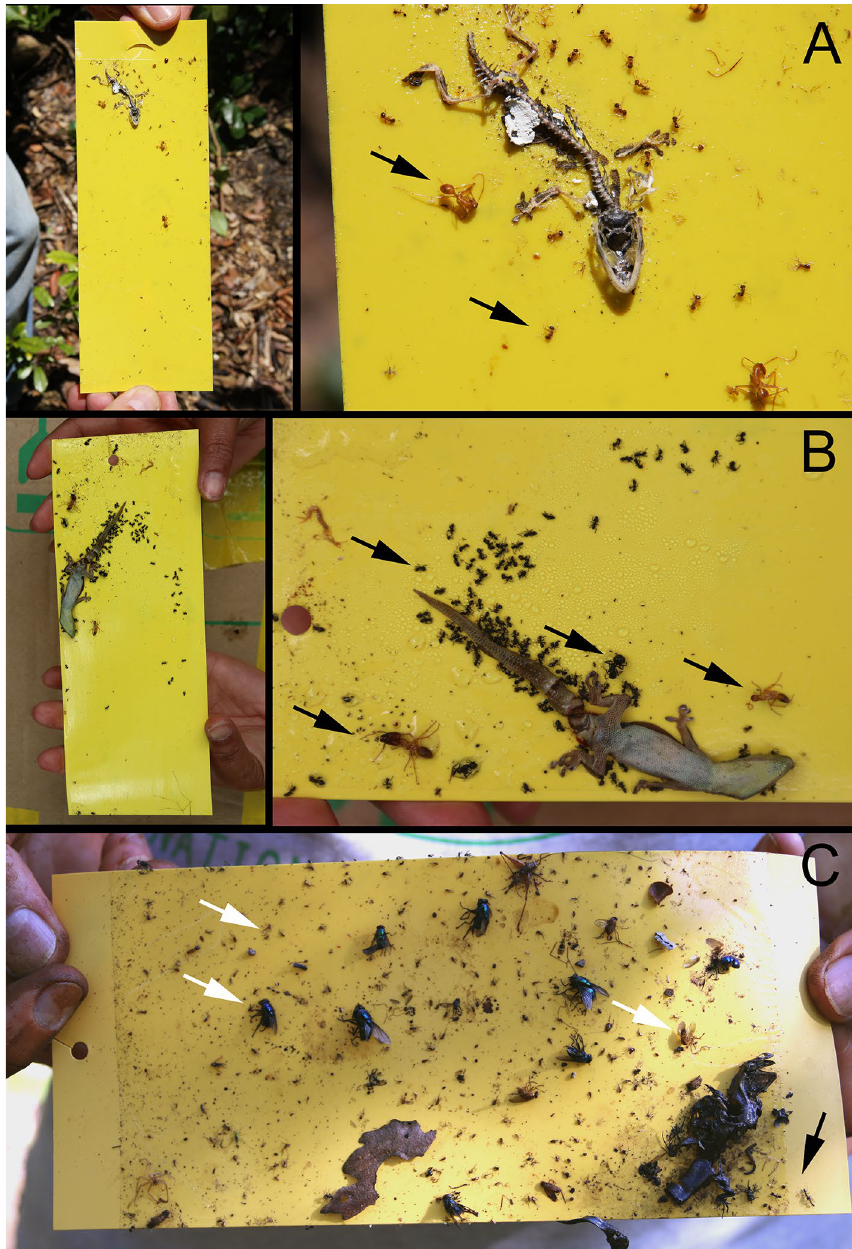
Figure 7. Extant taphonomic correlates from actualistic field research in Madagascar and New Caledonia using yellow sticky traps on trunks of the resinous tree species Hymenaea verrucosa (Fabaceae) and Agathis lanceolata (Araucariaceae), respectively. ( A ) Gecko trapped on sticky trap placed on the tree H4 at 2 m height on the Hymenaea trunk; note abundant specimens of two ant morphotypes (two black arrows) of different size which became trapped from the numerous ants that detected the gecko carcass and skeletonized it. ( B ) Gecko trapped on sticky trap placed on the tree 3R2 at 1 m height on the Hymenaea trunk; note abundant specimens of four ant morphotypes (four black arrows) of very diverse sizes which became trapped before skeletonization of the gecko carcass. ( C ) Gecko carcass on sticky trap (down right) placed on the tree NCR 25 at 0 m height on the Agathis trunk; note abundant specimens of at least three fly morphotypes of Muscidae, Dolichopodidae and Phoridae (three white arrows) of very diverse sizes which became trapped when attracted by the gecko carcass and three ants (black arrow) visiting the carcass but not trapped; however, the smaller morphotype (Phoridae) is also very abundant in the main part of the other sticky traps in this station with or without trapped geckos. (A and B) from campaign 2013 in Ambahy community (Nosy Varika, Mananjary region) (20° 46 ′ S, 48° 28 ′ E) and from campaign 2017 in Andranotsara forest, 40 km south of Sambava city (14° 38 ′ S, 50° 12 ′ E), respectively (both areas at the east coast of Madagascar; more information in Delclòs et al., 2020). (C) from campaign 2016 in Faux Bon Secours forest, South of New Caledonia (22° 10 ′ S, 166° 41 ′ E). Trap width 7.35 cm in ( A ), 7.50 cm in ( B ), 10.00 cm in ( C